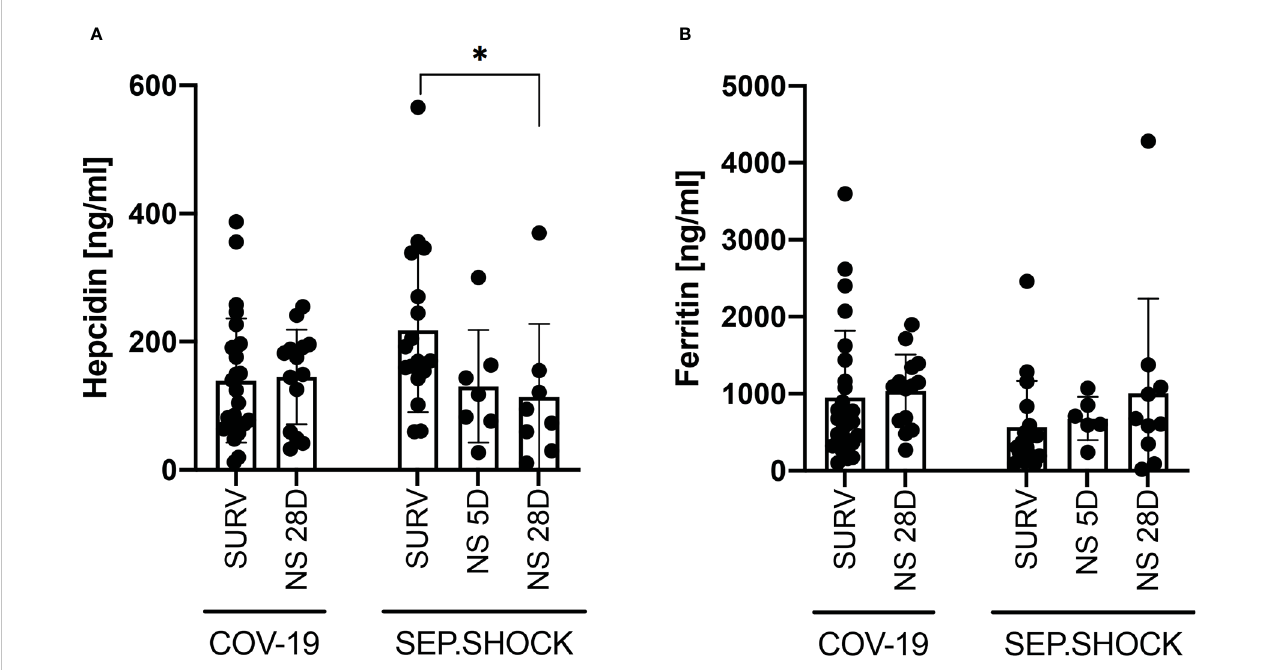
FIGURE 2 Hepcidin and ferritin levels in infectious disease cohorts (TP1) by patient survival status. (A, B) No signi fi cant differences in (A) hepcidin or (B) ferritin levels were observed between survivors and the 28D mortality group in the COVID-19 cohort. In the septic shock cohort, hepcidin levels at TP1 were signi fi cantly higher ( P = 0.023) in survivors than in the 28D mortality group, while the difference between survivors and the 5D mortality group was not signi fi cant ( P = 0.075). (B) The mean ferritin level was higher in the 28D mortality group than in the survivor group, but this difference was not signi fi cant ( P = 0.264). Statistical comparisons were performed using the Mann-Whitney test. NS, non-survivor; SURV, survivor. * P <